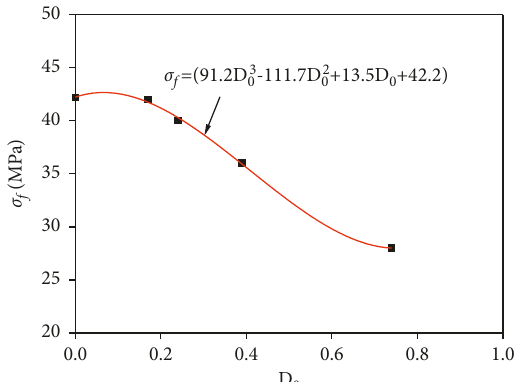
Figure 7: Fitting relationship of peak stress with a predamaged degree.